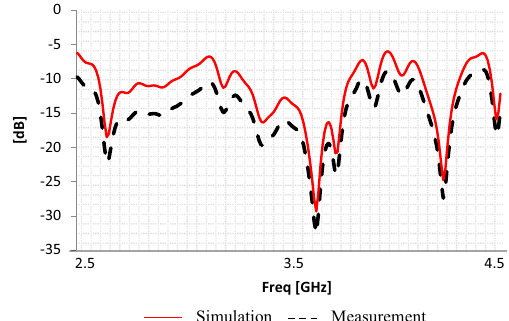
Fig. 11 Comparison of S-parameter 4